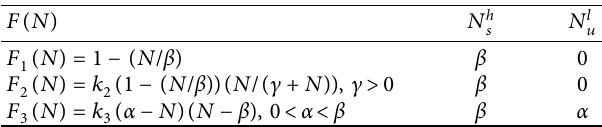
Table 1: Intraspecific growth submodels of wild-type insect growth rate.